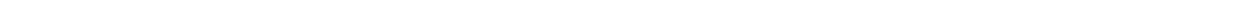
Fig. 4 TERRAs bind PRC2 and modulates its own and HP1 recruitment to telomeres. a A TERRA biotinylated RNA oligo (S) was incubated with nuclear extracts from U2OS cells and their association with Ezh2 and SUZ12 was detected by western blotting. A biotinylated control RNA oligo corresponding to the complementary sequence (AS) of the same length as the biotinylated TERRA (N 48 ) was used as control. Biotin pull-down in the absence of RNA oligo (no oligo) was included to monitor inespeci fi c binding to the beads. b Representative images of the average number of colocalizations found on double immunostaining to TRF2 (green) and SUZ12 (red) in the U2OS WT and 20q-KO clones. Arrowheads indicate colocalization events. Scale bar, 10 μ m. (Left graph) Quanti fi cation of the colocalization in each of the WT and 20q-TERRA KO clones (mean values ± s.e.m., n = number of cells) and (right graph) in all WT vs. the 20q-TERRA KO clones (mean values± s.e.m., n = independent clone). c Telomeric ChIP-dot-blot of SUZ12 in U2OS cells infected with scramble or SUZ12 shRNA. IgG was used as a control. DNA input is also shown. (Graph) Quanti fi cation of the signal from the immunoprecipitated telomeric repeats normalized by the input (mean values± s.e.m., n = technical triplicates). d Representative confocal STED super-resolution images showing the colocalization between TRF2 (in green) and SUZ12 (in red) in U2OS cells. Zoom: a colocalization event. Scale bar 5 μ m. e Telomeric ChIP-dot-blot for HP1 in WT and 20q-TERRA KO clones. IgG was used as a control. DNA input signal is also shown. (Left graph) Quanti fi cation of the signal from the immunoprecipitated telomeric repeats normalized by the input for each individual sample and (right graph) for all WT vs. 20q-TERRA KO clones (mean values ± s.e.m., n = independent clone). Student ’ s t -test was used for statistical analysis (* p < 0.05 and ** p <